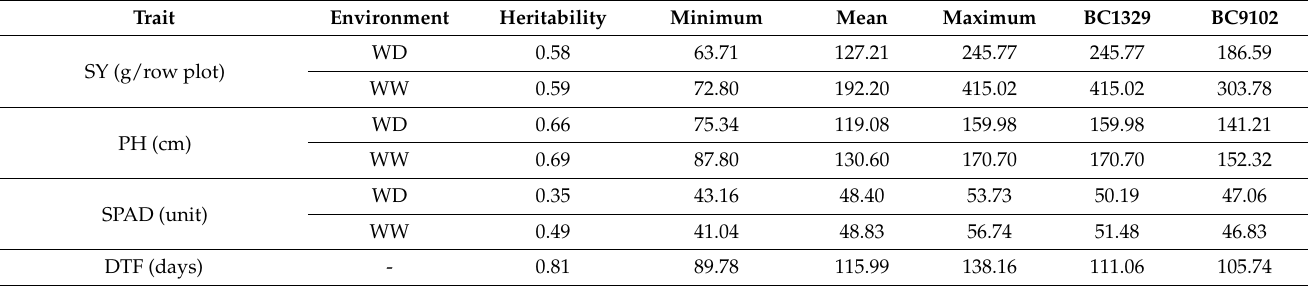
Table 3. Summary of heritability, mean, minimum and maximum values for each trait in the doubled haploid population from BC1329/BC9102 together with their parental lines. SY: Seed yield; PH: Plant height; SPAD: Chlorophyll content; DTF: Days to flower; WD: Water-deficit block; WW: Well-watered block. Total (additive plus non-additive) common genotype by environment empirical best linear unbiased predictions are summarised for the traits SY, PH, and SPAD, and total genotype empirical best linear unbiased predictions are summarised for